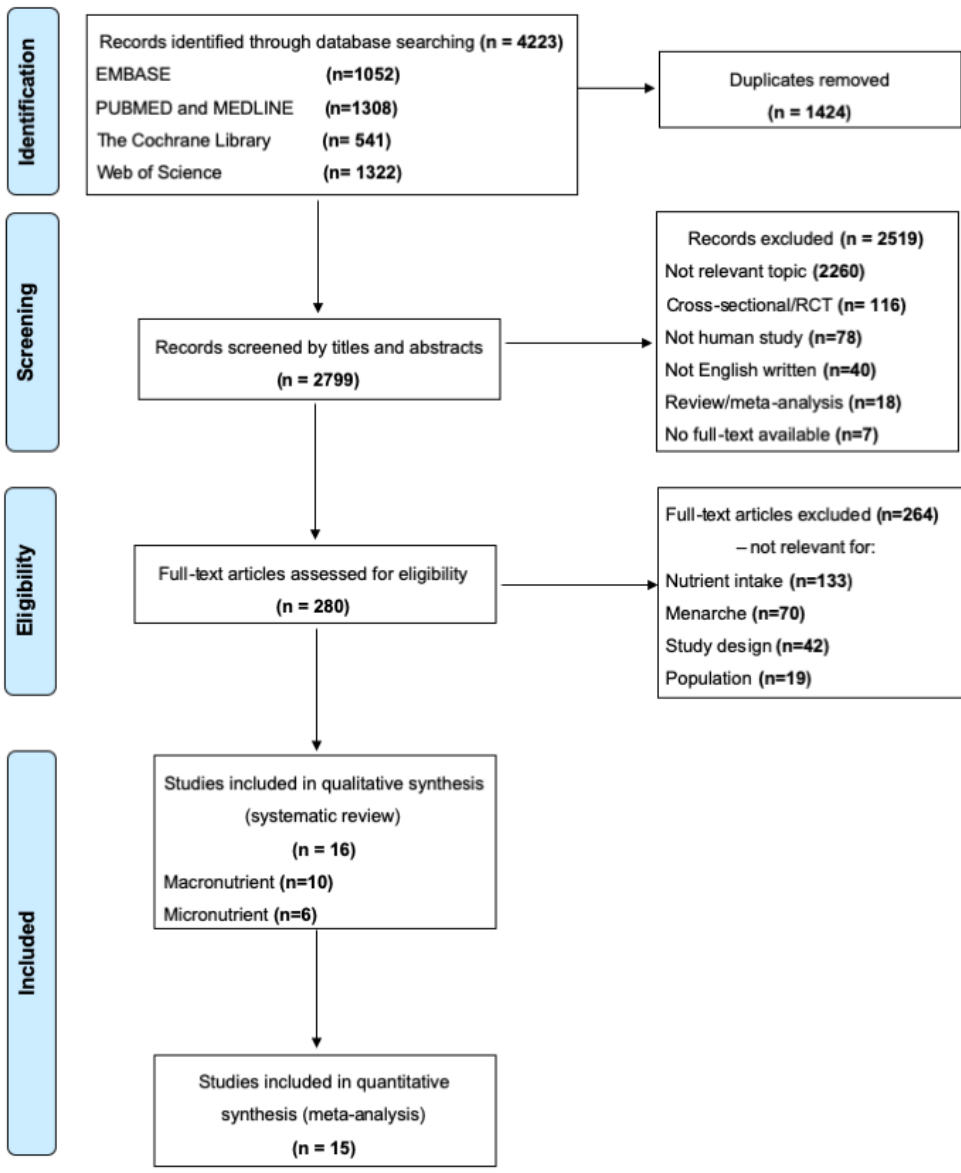
Figure 1. Study flow chart. Definition of abbreviations : EMBASE, Elservier database; RCT, randomized controlled trial.